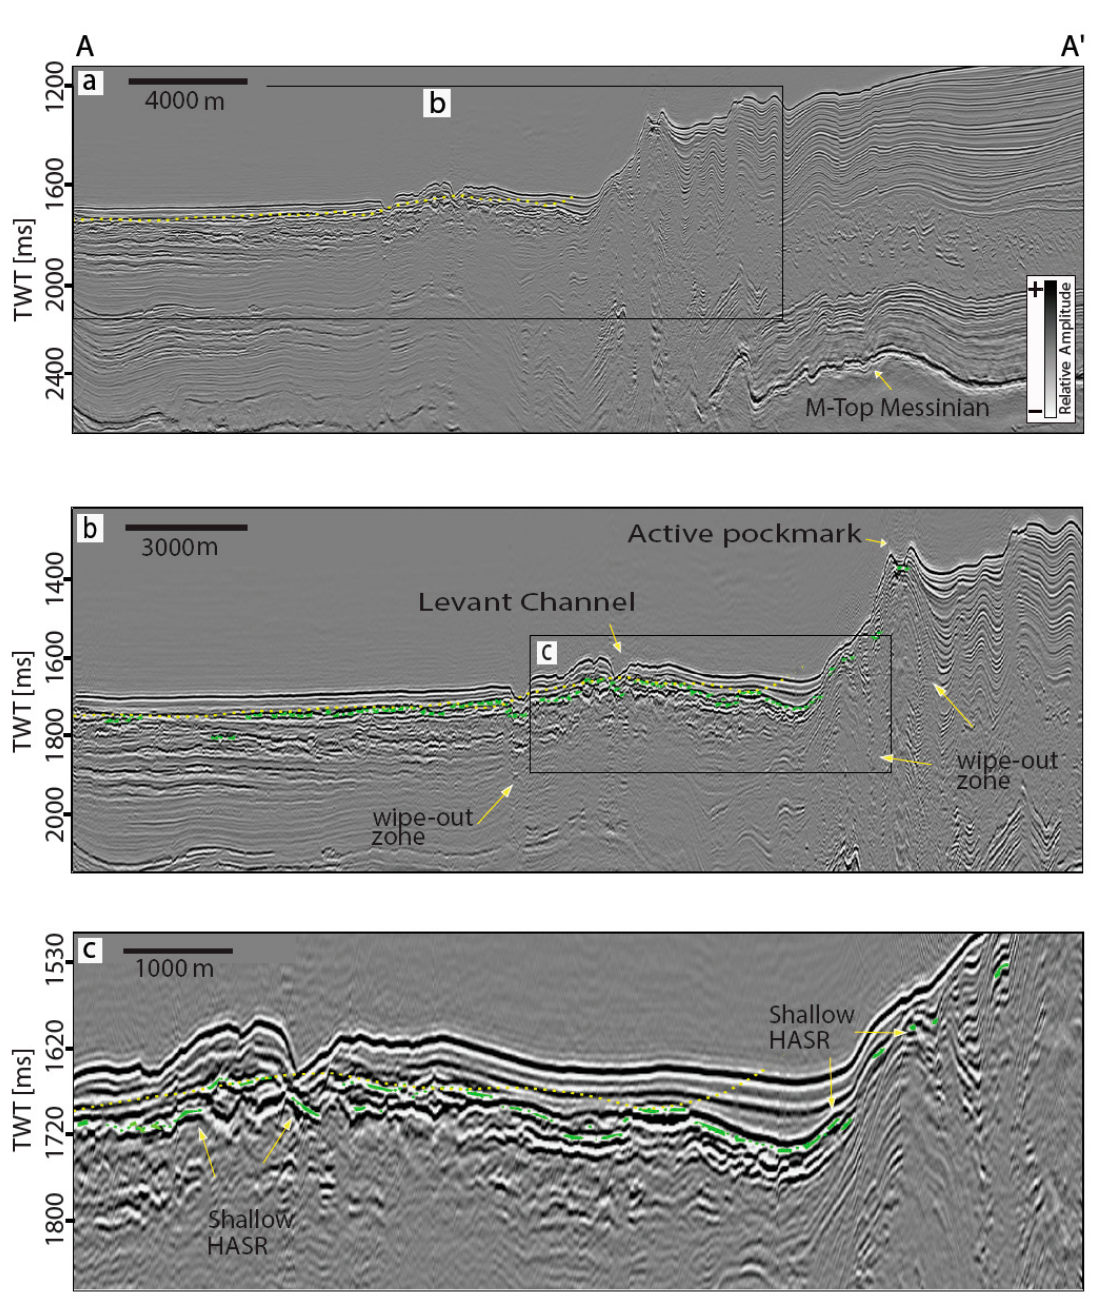
Figure 6. Seismic time migrated section A-A’ (Figure 1) of the Southern Israel 3D data. The yellow dashed line represents the base GHSZ modeled with a thermal gradient of 28.5 ◦ C / km on the regional bathymetric digital elevation model (DEM), while green dots represent the automatic HASR picks. ( a ) The full extent of the section down to the top of the Messinian evaporites (M). ( b ) A zoom on the rectangle in ( a ), showing the positions of ROV-surveyed active methane seepage site at the top pockmark of Palmahim disturbance and in the Levant Channel [69–71,84] and the Shallow HASR. ( c ) A zoom on the Levant channel area (the rectangle in ( b )) showing the segmented appearance and mostly negative polarity of the HASR.